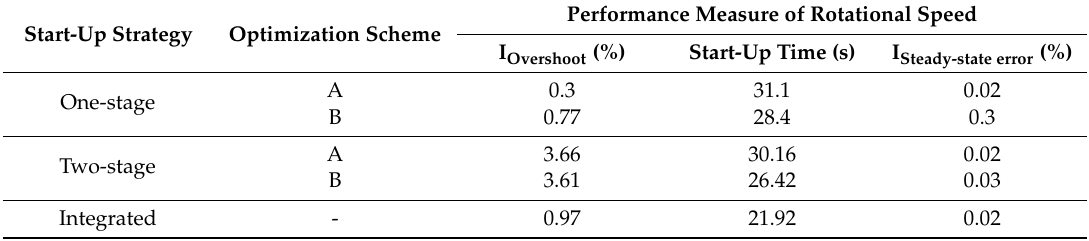
Table 13. Performance indices of the variable start-up strategy of PSU with different